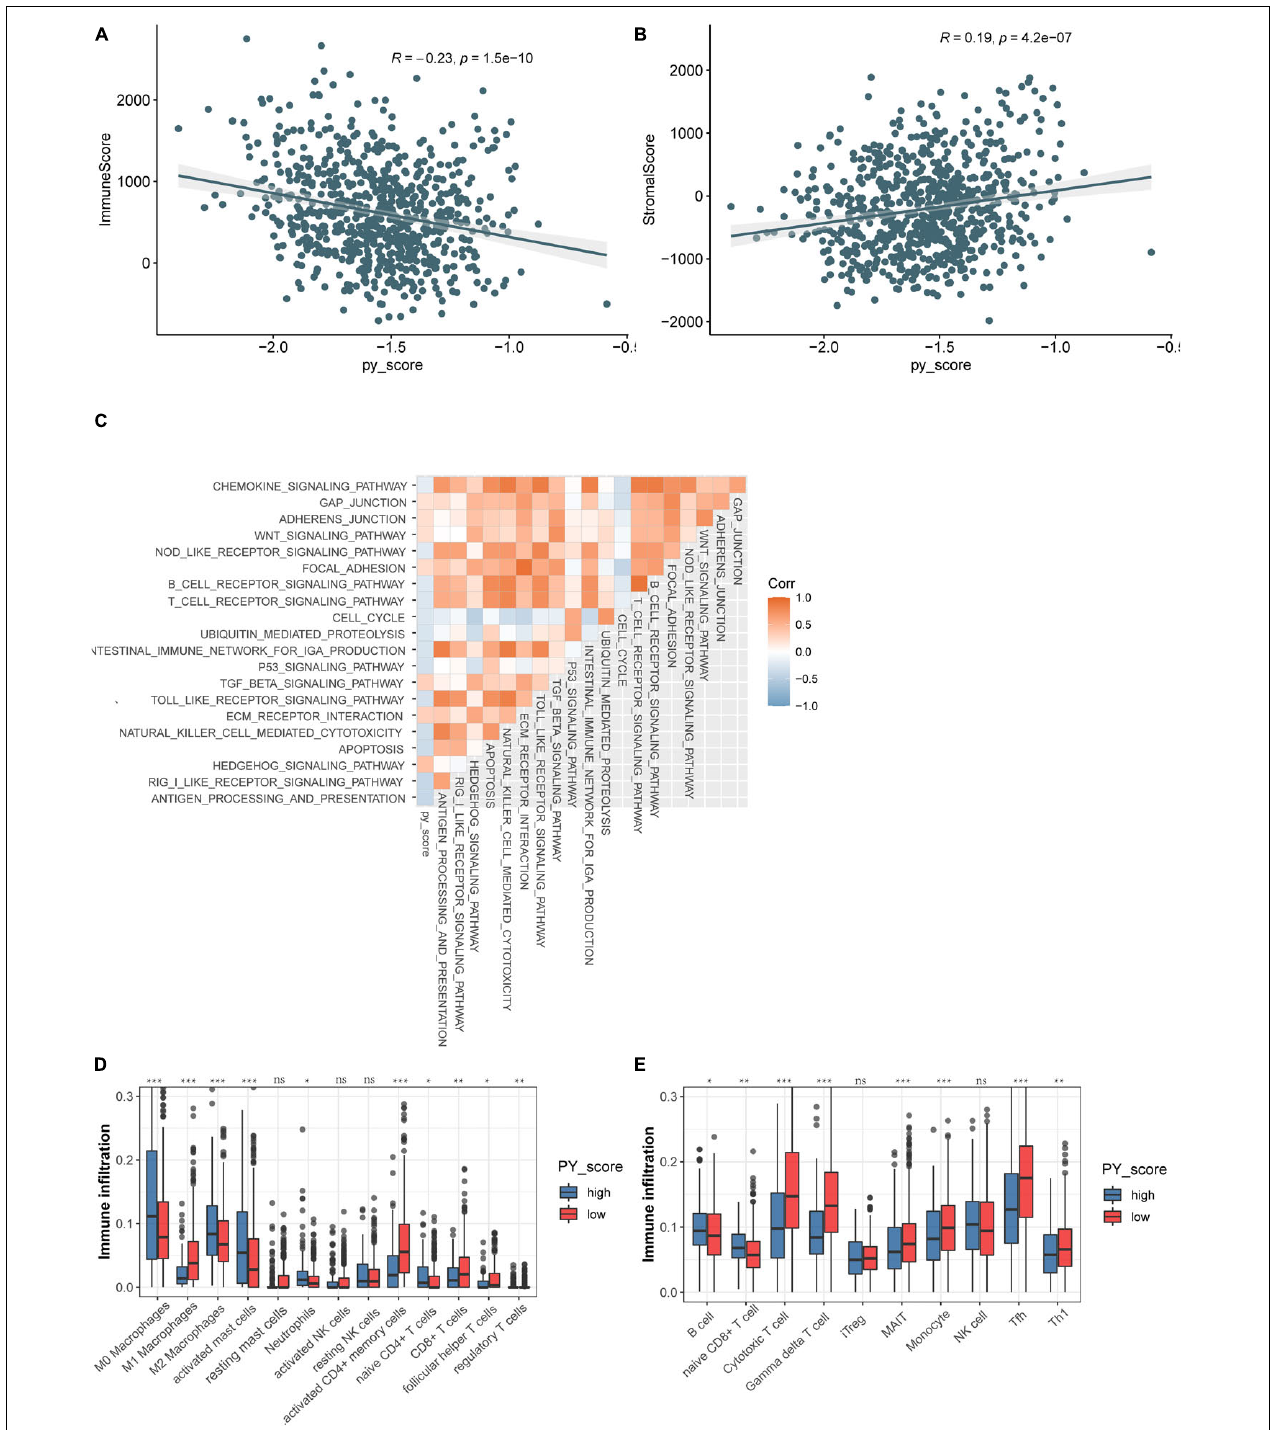
FIGURE 7 | Function annotation of the pyroptosis score (PY-score). (A,B) Relationships between the immune score and PY-score (Spearman’s test: p < 0.0001) (A) and the between the stromal score and PY-score (Spearman’s test: p < 0.0001) (B) in the meta-GEO cohort. (C) Correlations between the PY-score and the known gene signatures in the meta-GEO cohort using Spearman’s analysis. A negative correlation is marked with blue and a positive correlation with orange . (D) Abundance of infiltrating immune cells in the high and low PY-score groups based on the CIBERSORT platform in the meta-GEO cohort. Asterisks represent the statistical p -value ( ns p > 0.05; * p < 0.05; ** p < 0.01; *** p < 0.001). (E) Abundance of infiltrating immune cells in the high and low PY-score groups based on the ImmuncellAI platform in the meta-GEO cohort. Asterisks represent the statistical p -value ( ns p > 0.05; * p < 0.05; ** p < 0.01; *** p < 0.001).